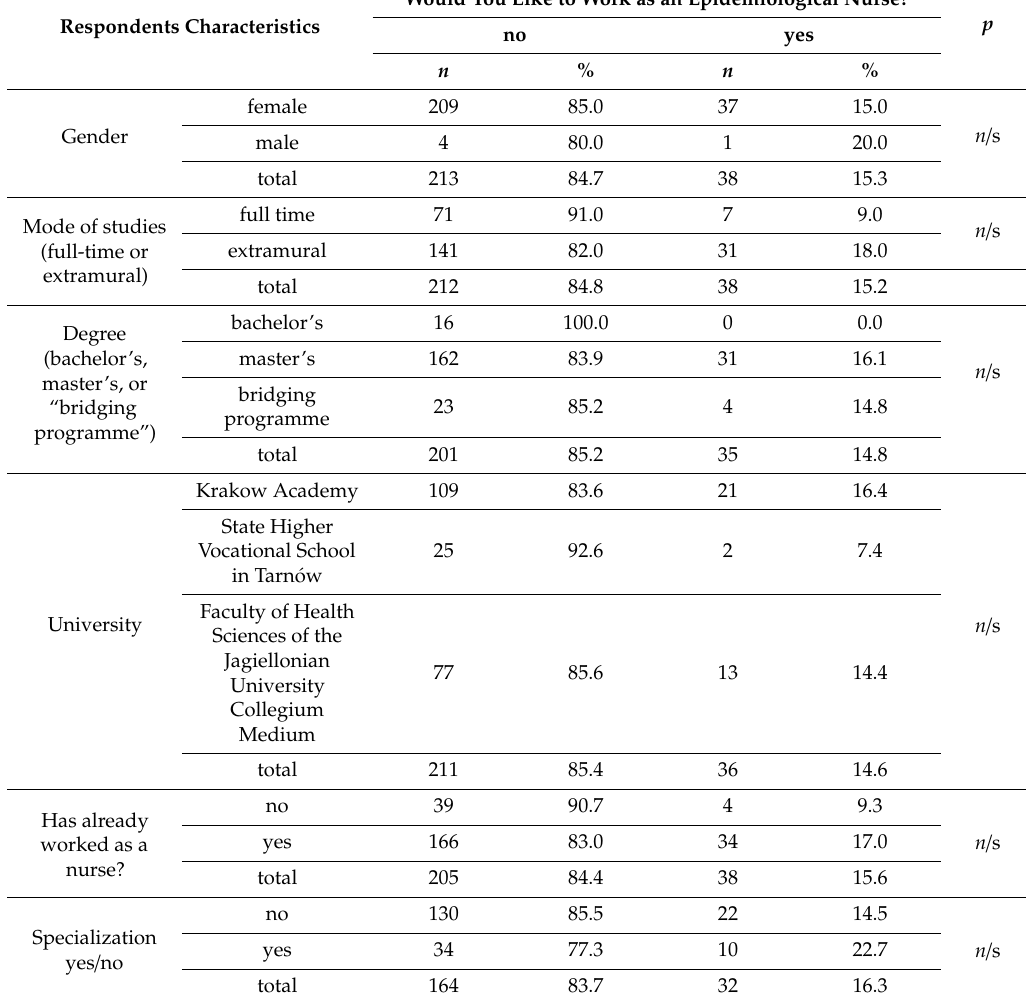
Table 1. Respondents’ declaration of willingness to work as an infection control nurse depending on sex, type and mode of study, and professional experience.